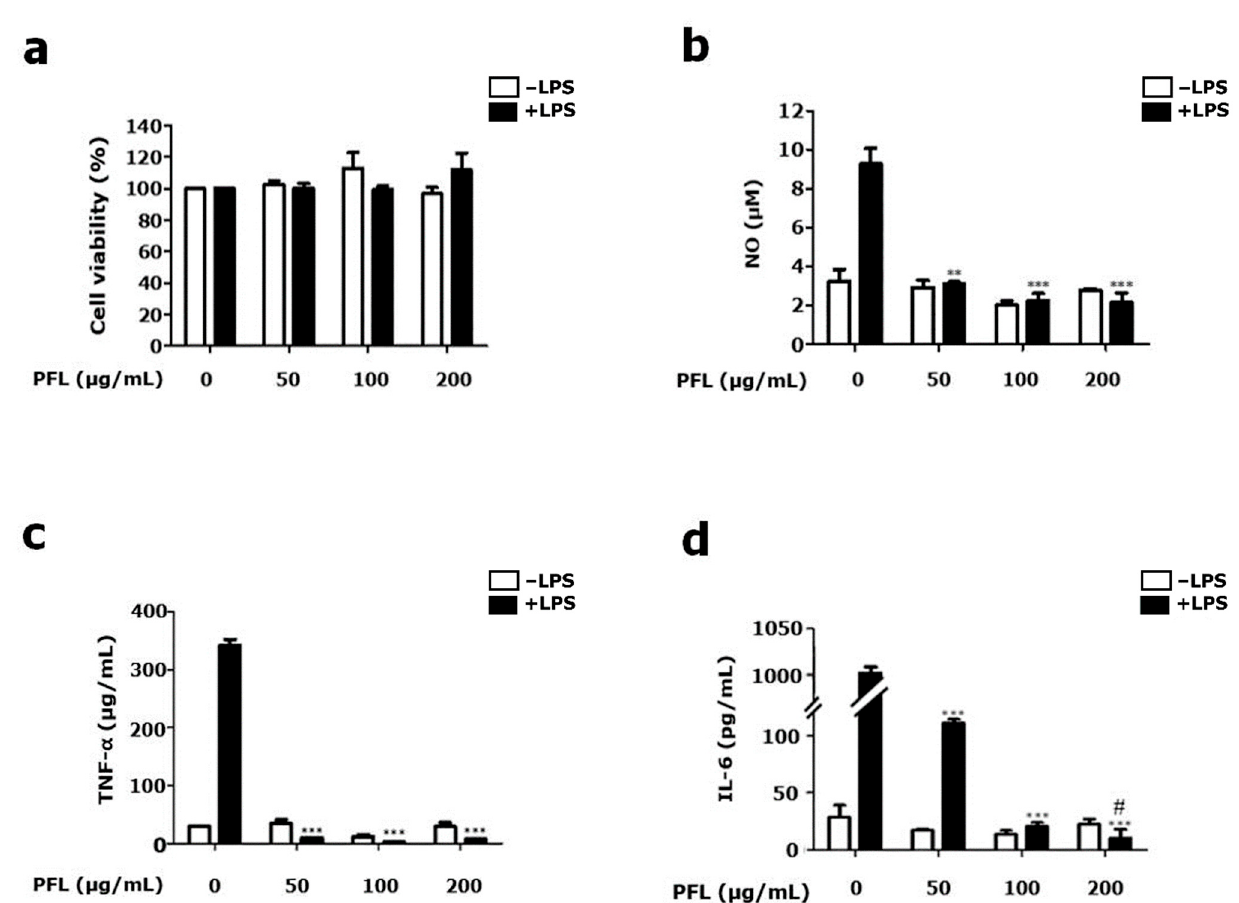
Figure 5. Effect of PFL on BV-2 microglial cell viability and NO, TNF- α , and IL-6 production. BV-2 cells were pretreated with the indicated doses of PFL for 12 h and further treated with 1 μ g/mL lipopolysaccharide (LPS). After 24 h, ( a ) cell viability was determined by the methyl thiazolyl tetrazolium (MTT) assay. Using enzyme-linked immunosorbent assay (ELISA) kits, the contents of ( b ) NO, ( c ) TNF- α , and ( d ) IL-6 in culture media were determined. Values are presented as the mean ± SEM (** p < 0.01 and *** p < 0.001 vs. PFL-untreated; # p < 0.05 vs. 50 μ g/mL PFL-treated).